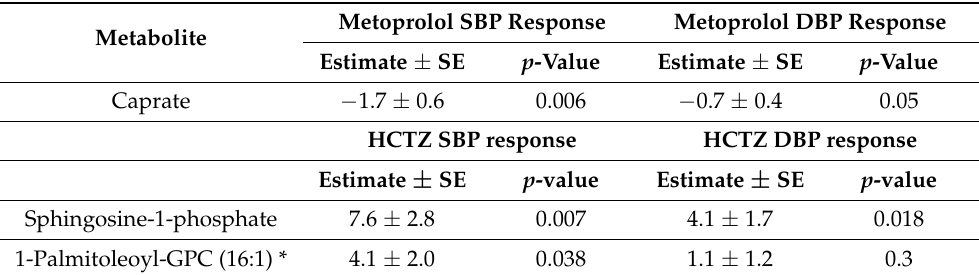
Table 4. Validated metabolites and replicated metabolites with nominal associations with BP re- sponses in the expected direction in PEAR